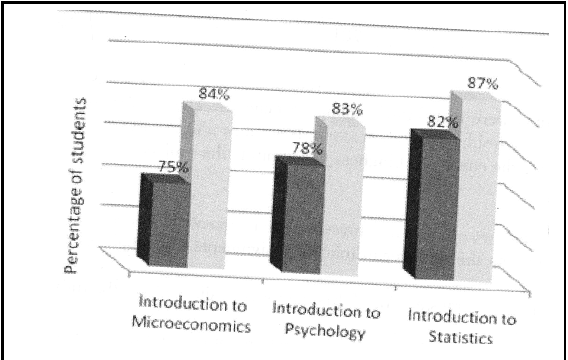
Figure 1. Percentage of students in the coached and non-coached groups handed in